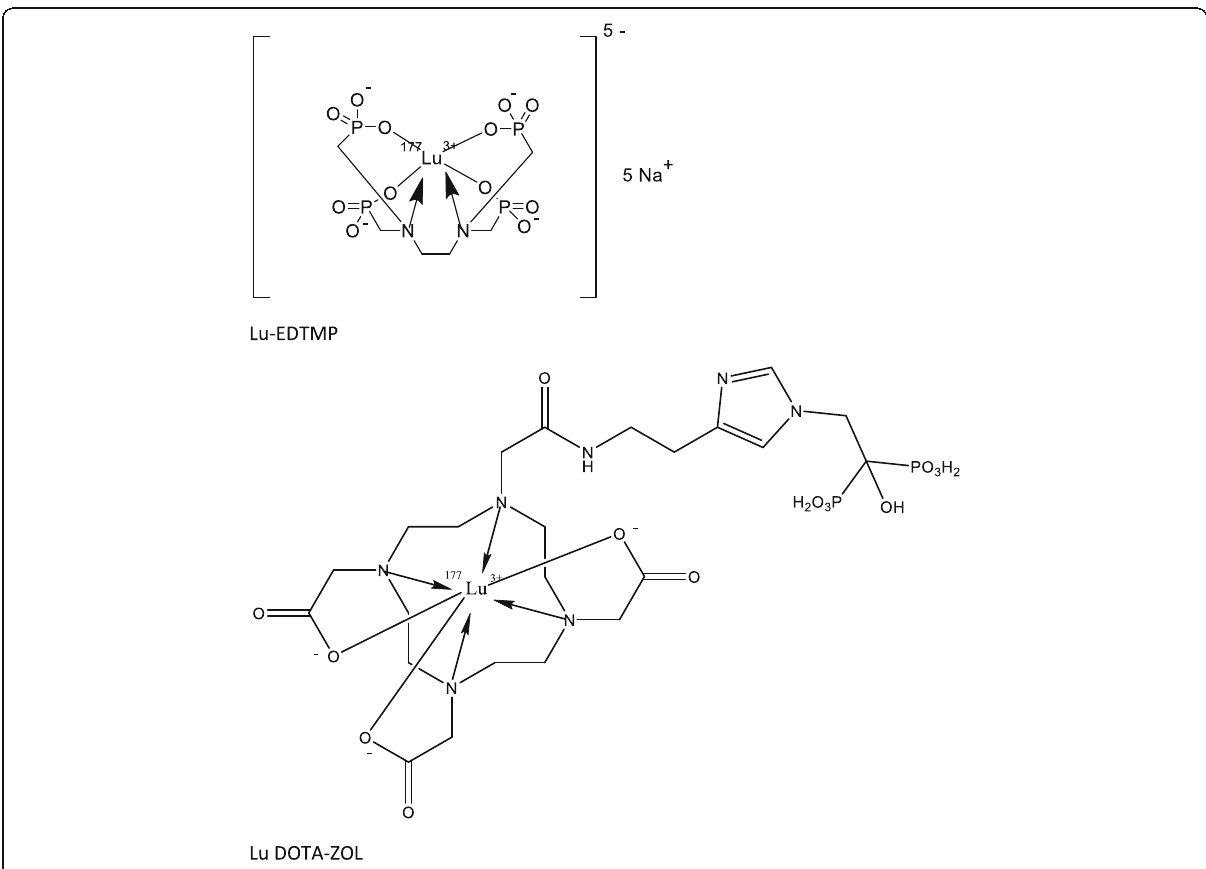
Fig. 2 Comparison of chemical structures of [ 177 Lu]Lu-DOTA ZOL and [ 177